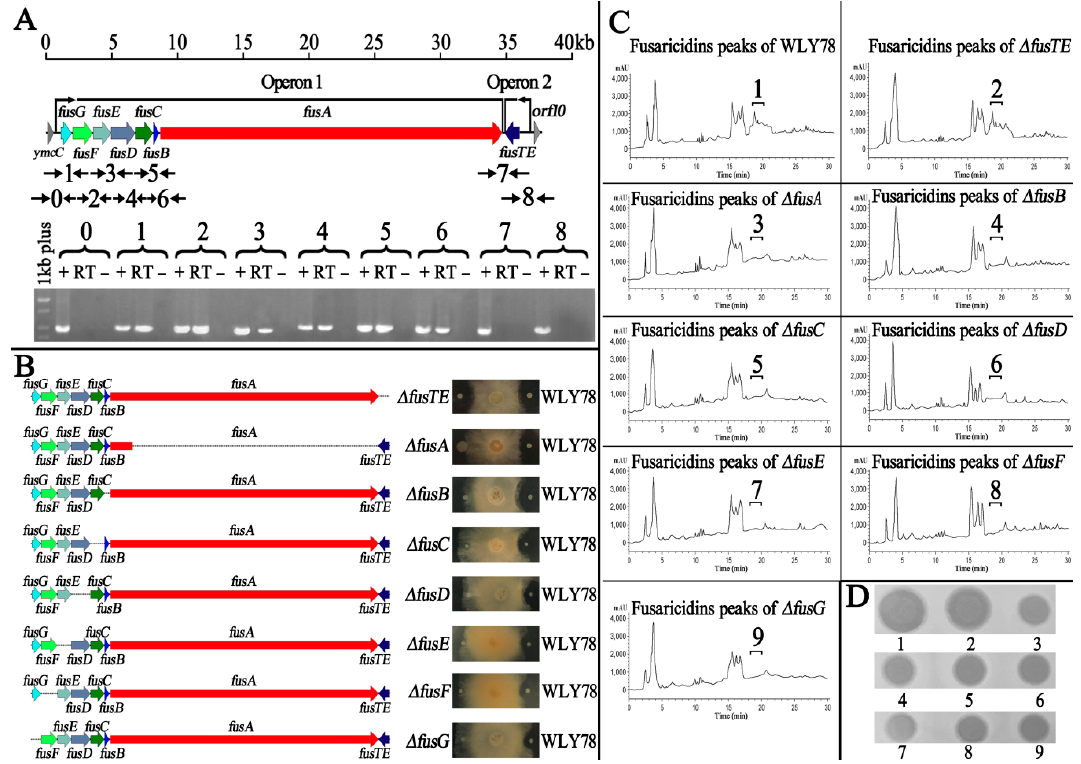
Figure 2. The fusTE is not involved in producing fusaricidins. Organization of the eight genes within the fus gene cluster in P. polymyxa WLY78 was determined by RT-PCR. The numbers on the top of the gels correspond to the product numbers drawn schematically in the outline given above. RT is the standard RT-PCR reaction; (–) is the negative control in which no reverse transcriptase was added to the RT reaction; (+) is the positive control in which genomic DNA was used as the template in the RT reaction ( A ). Antifungal activity of fus gene mutants ( fusA ‐ , Δ fusB , Δ fusC , Δ fusD , Δ fusE , Δ fusF , Δ fusG , and Δ fusTE ) against F. oxysporum f. sp. cucumerium ( B ). Collection of fusaricidins extracted from